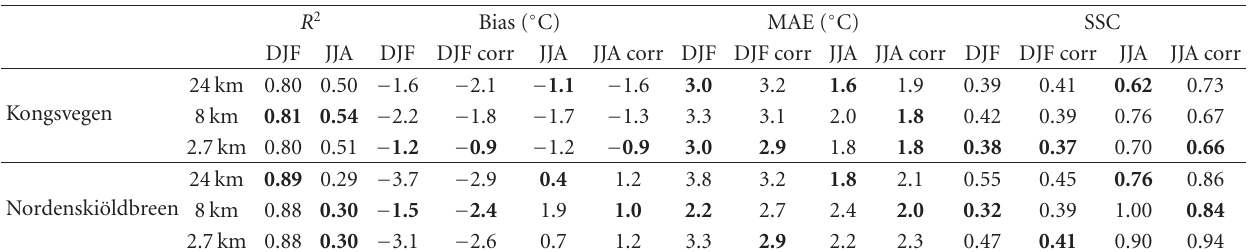
Table 3: Statistical evaluation of temperature in summer and winter 2009-2010. Bold numbers indicate the best result for each AWS. Vestfonna data are not used here because of the lack of data during the chosen period. Abbreviation corr denotes height corrected